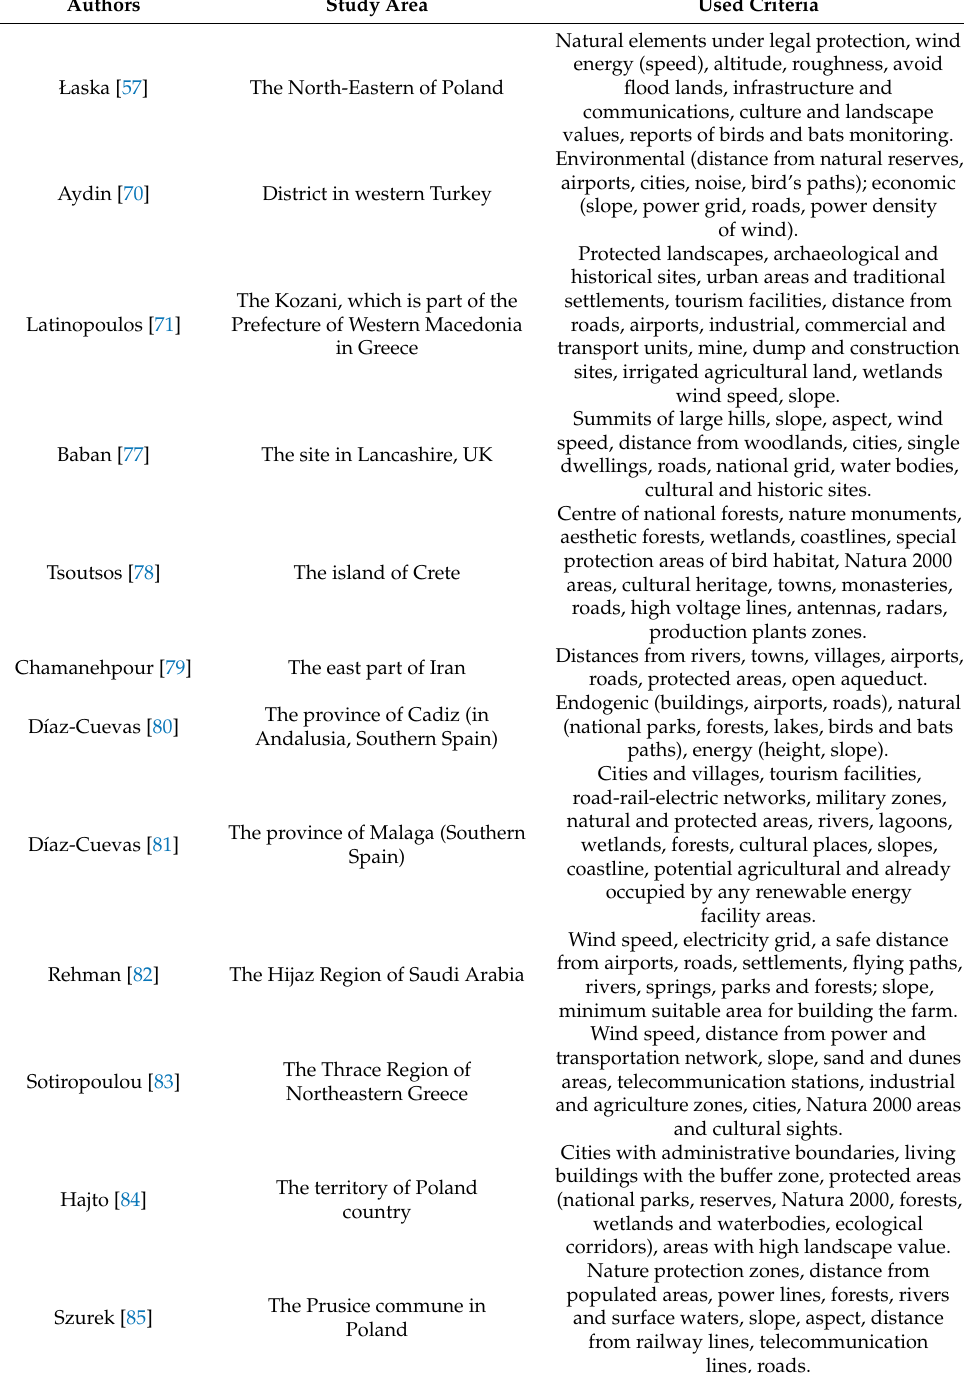
Table 4. Criteria used in previous